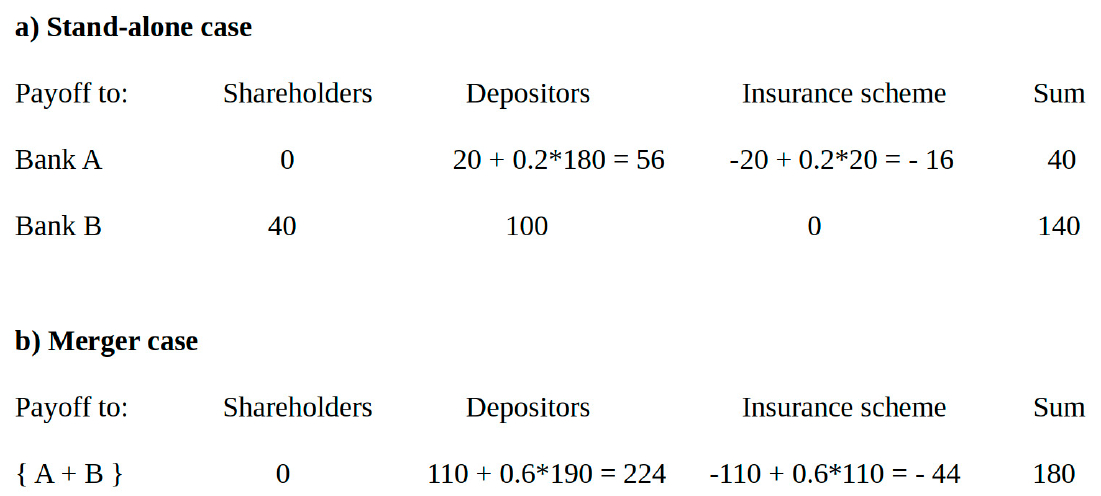
Figure 2. Bank Merger and Deposit Insurance (Numerical Example).